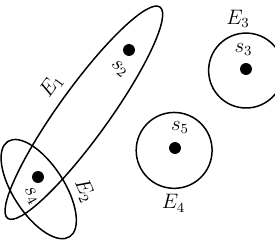
Figure 4. Representation of granules in a level through the